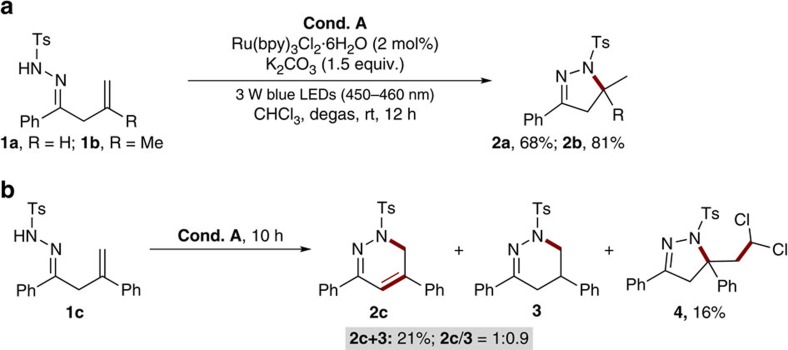
Initial results.(a) Reaction of substrate 1a and 1b under condition A. (b) Reaction of substrate 1c under condition A. Unless otherwise noted, condition A: reaction were run with 1 (0.2 mmol), Ru(bpy)3Cl2·6H2O (2mol%), K2CO3 (0.3 mmol), 3 W blue light-emitting diodes (450–460 nm) irradiation and CHCl3 (4.0 mL) at rt for 10–12 h.